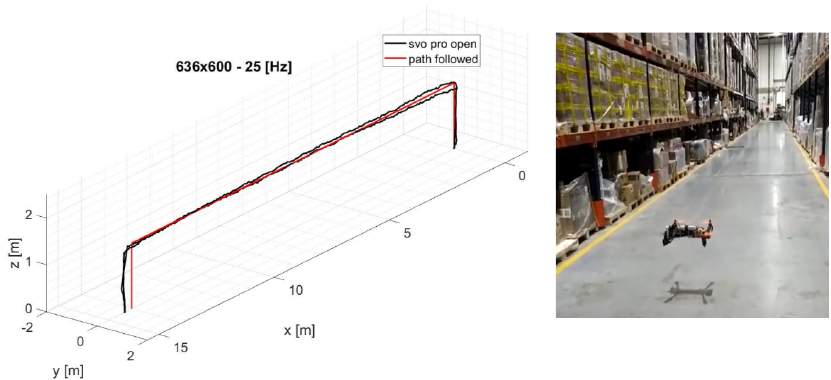
Figure 9. Example of a trajectory estimated inside the warehouse, with a resolution of 636 × 600 px at a sampling rate of 25